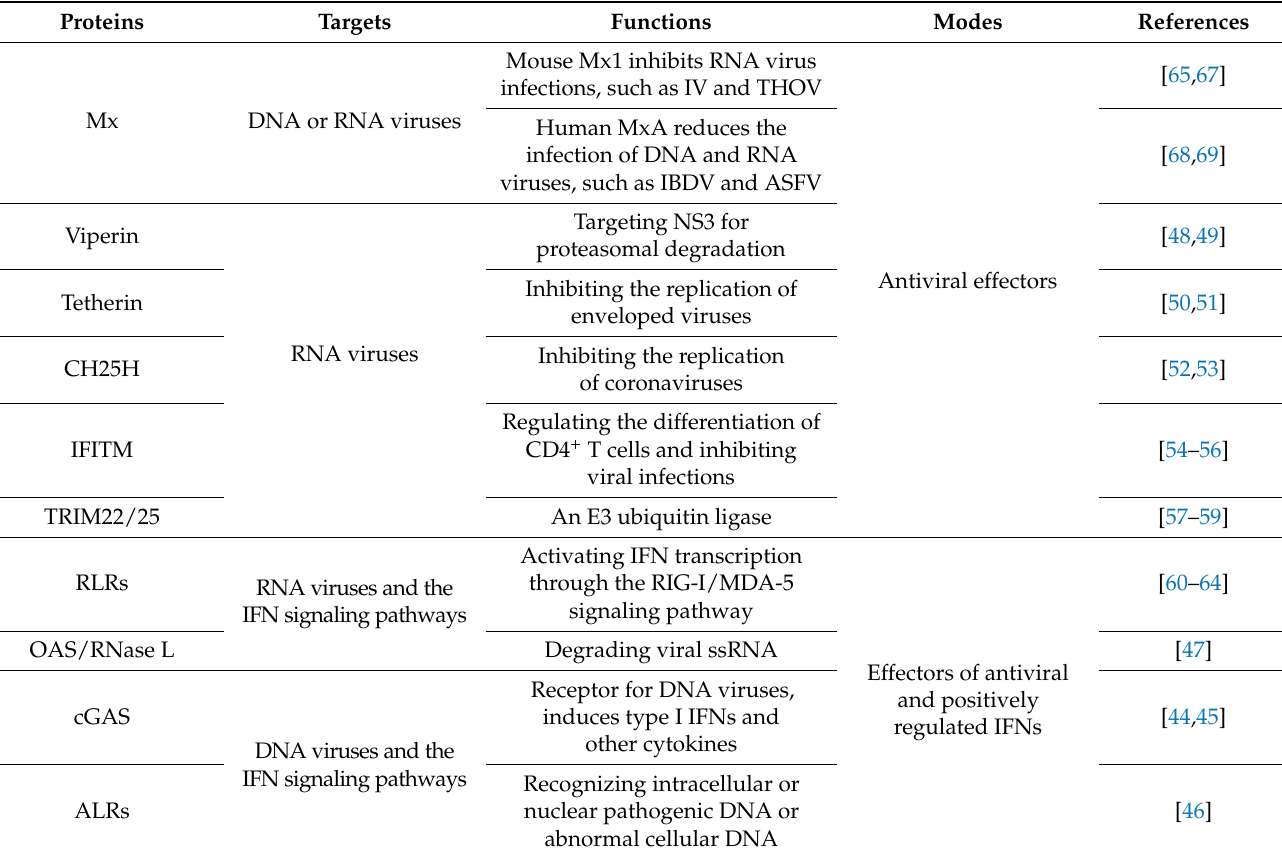
Table 1. Functions of ISGs-encoded